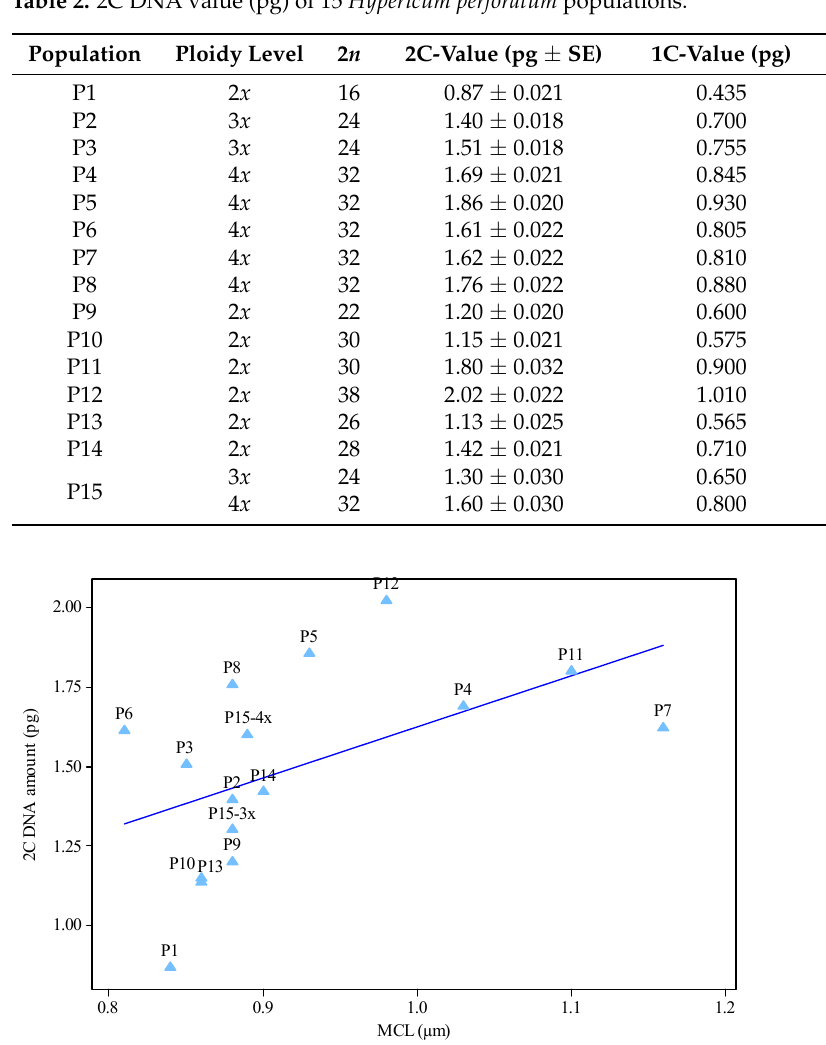
Figure 6. Linear relationship between 2C DNA amount (pg) and chromosome length (b = 1.25 ** p < 0.01) of 15 Hypericum perforatum populations.